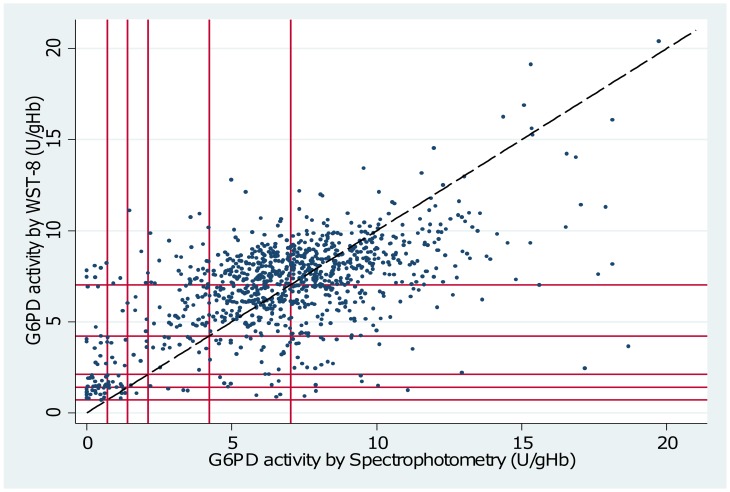
Scatter plot of G6PD activity measured by Spectrophotometry vs. WST-8.Diagonal line = line of equality. Starting from origin outwards vertical and horizontal lines mark 10%, 20%, 30%, 60% and 100% activity of the adjusted male median based on spectrophotometry and WST-8 respectively.